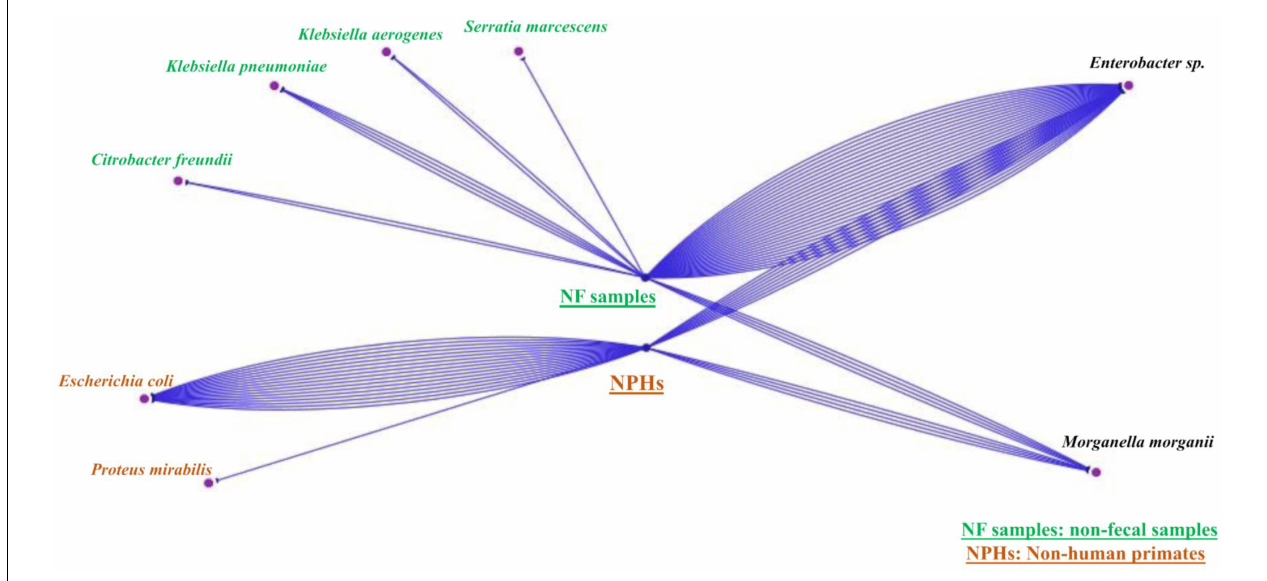
FIGURE 2 | Simple view of the Cytoscape visualizing unique and common species of the two samples’ types (NHPs and non-feacal samples). The blue lines represent the number of strains found each type. There are strains that belong just to non-fecal environmental samples, others that belong just to NHPs and strains that can be found in both of